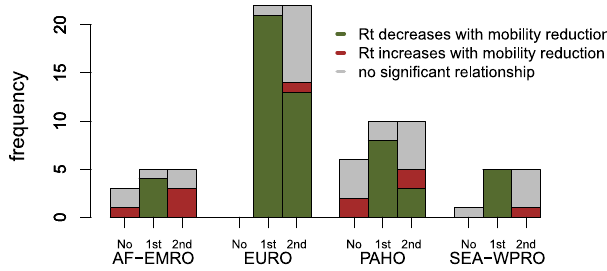
Fig. 3 Summary of relationship between mobility and transmissibility. Frequency of countries for which we found a signi fi cantly decreasing, increasing, or no clear relationship between mobility and transmissibility (green, red and grey bars respectively). For each WHO region, we further divided countries for which no change in relationship was inferred (labelled “ No ” ), and for those where a change in relationship was signi fi cant, we plot separately the nature of the relationship during the fi rst and second time periods (labelled “ 1st ” and “ 2nd ” respectively). Some WHO regions were aggregated, with AF-EMRO corresponding to the African and Eastern Mediterranean Regions, EURO corresponding to the European Region, PAHO corresponding to the Pan-American Region, and SEA-WPRO corresponding to the South-East Asia and the Western Paci fi c